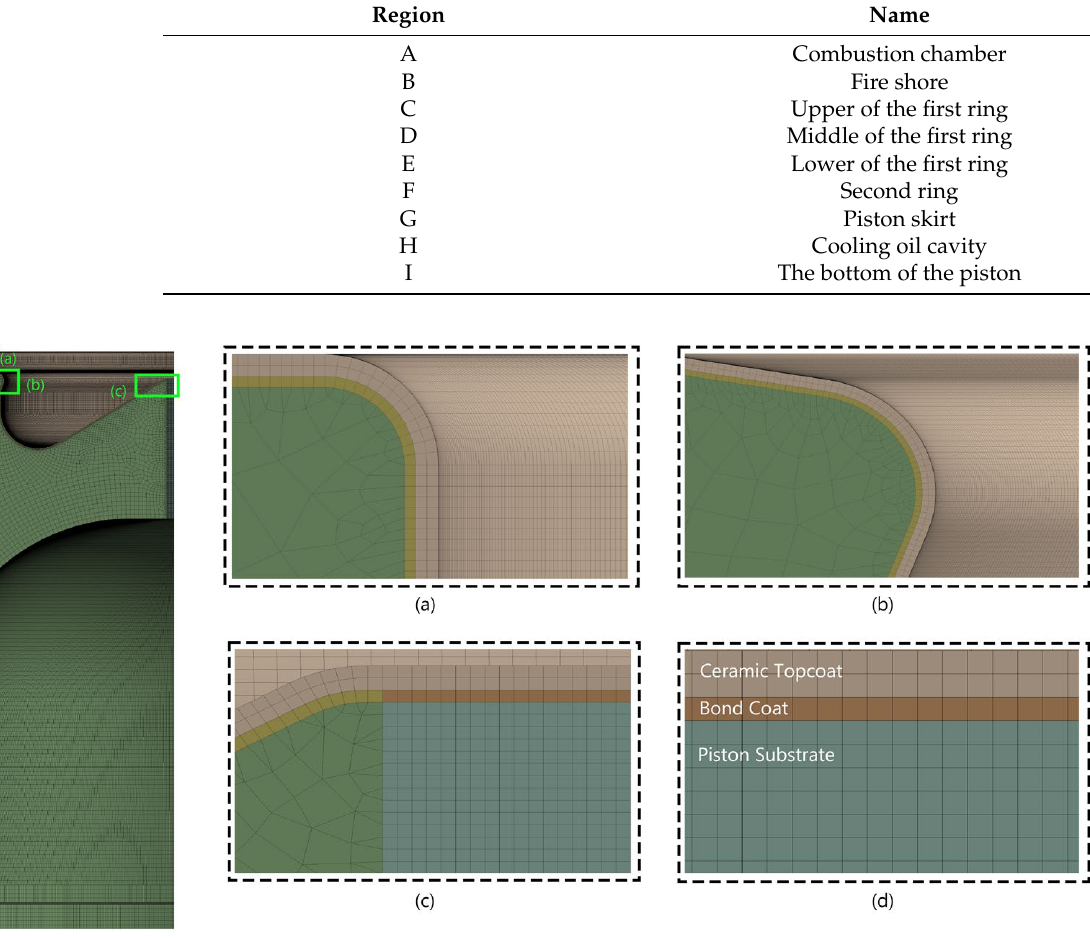
Figure 4. The one-quarter piston model: ( a – c ) the section view of refined mesh, ( d ) model structure diagram.